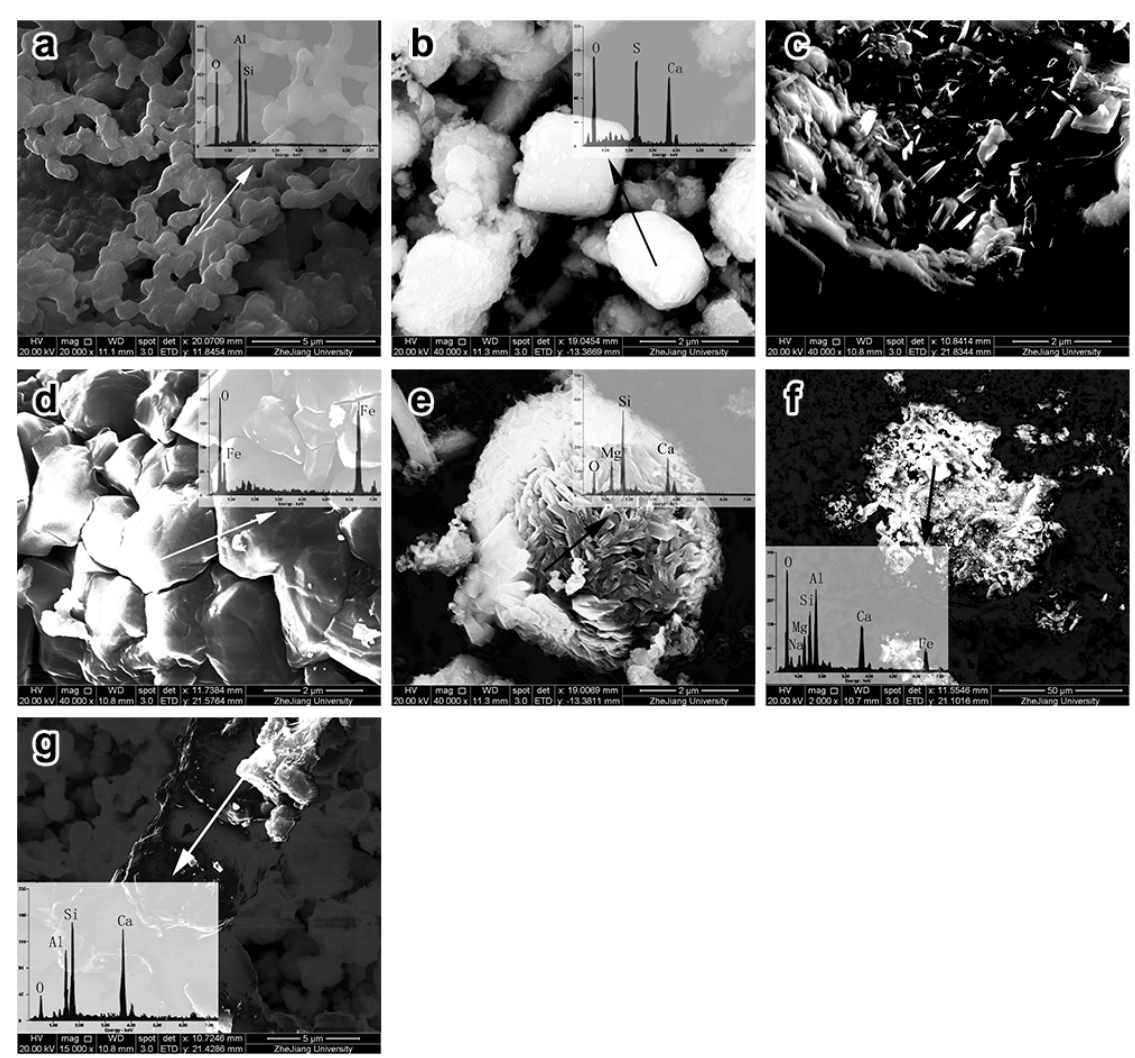
Figure 4. Scanning Electron Microscopy (SEM) and Energy Dispersive X-Ray (EDX) spectra of the mineral phases found in the ash samples: ( a ) crystal of mullite in G100 at 1300 °C; ( b ) crystal of anhydrite in D100 at 900 °C; ( c ) crystal of magnetite in D10G90 at 1200 °C; ( d ) morphology of merwinite in G10D90 at 1200 °C; ( e ) crystal of diopside